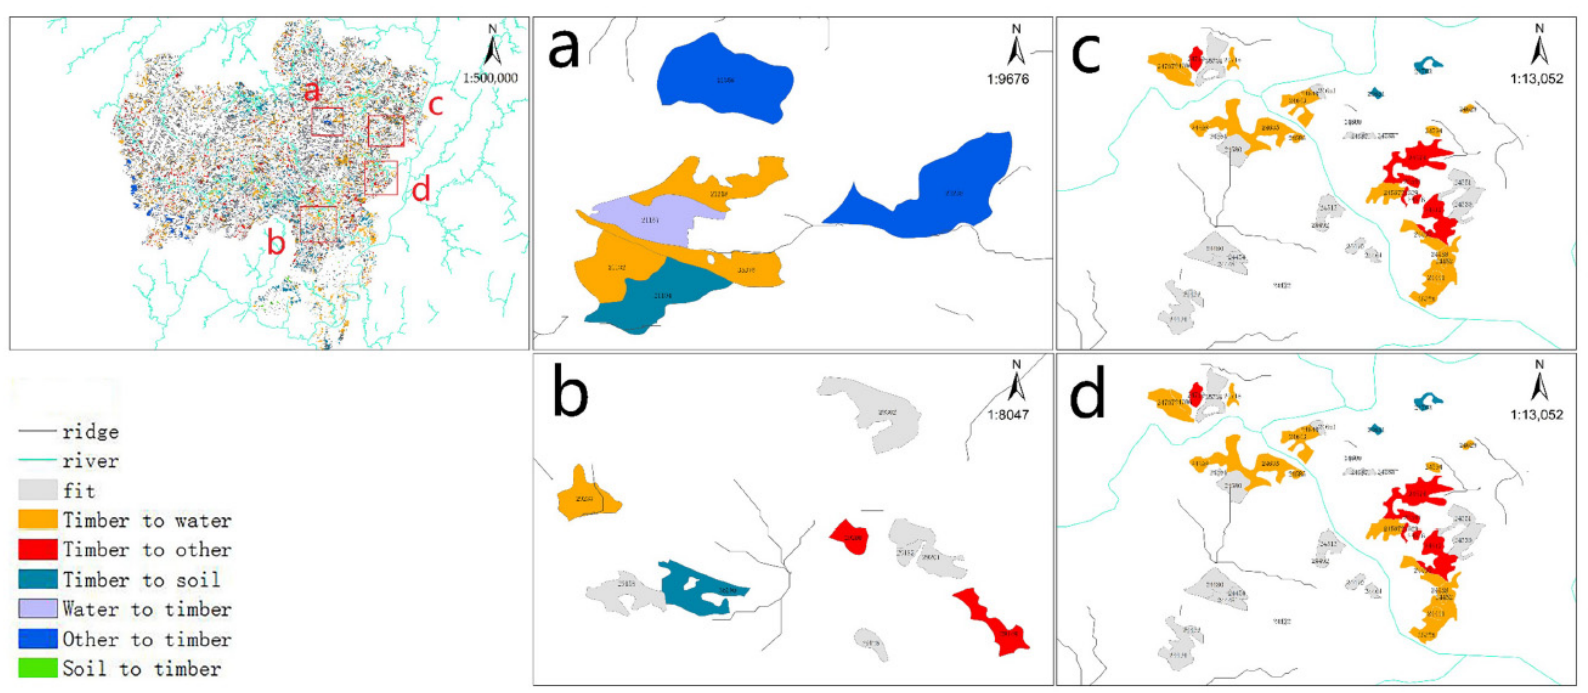
Figure 7. Spatial distribution of oriented functions of subcompartments. ( a ) indicates that the dominant function of the subcompartment is transformed from other ecological functions to wood functions, ( b ) indicates that the dominant functions of subcompartments are transformed from wood production functions to water and soil conservation functions, that of ( c ) subcompartments changes from wood production functions to water conservation functions, and ( d ) indicates that the dominant functions of sub-compartments transform from water conservation to wood production.